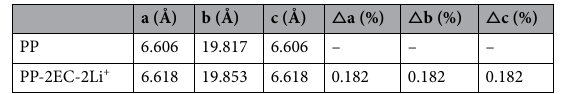
Table 6. Difference in the lattice constant of